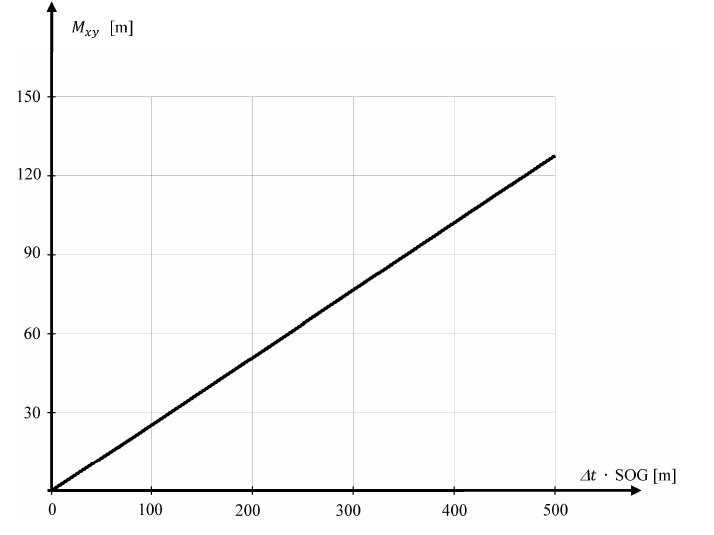
(cid:4674)0 0 (cid:34) (cid:35) 0(cid:4675) , 0 0 0 , 0 0